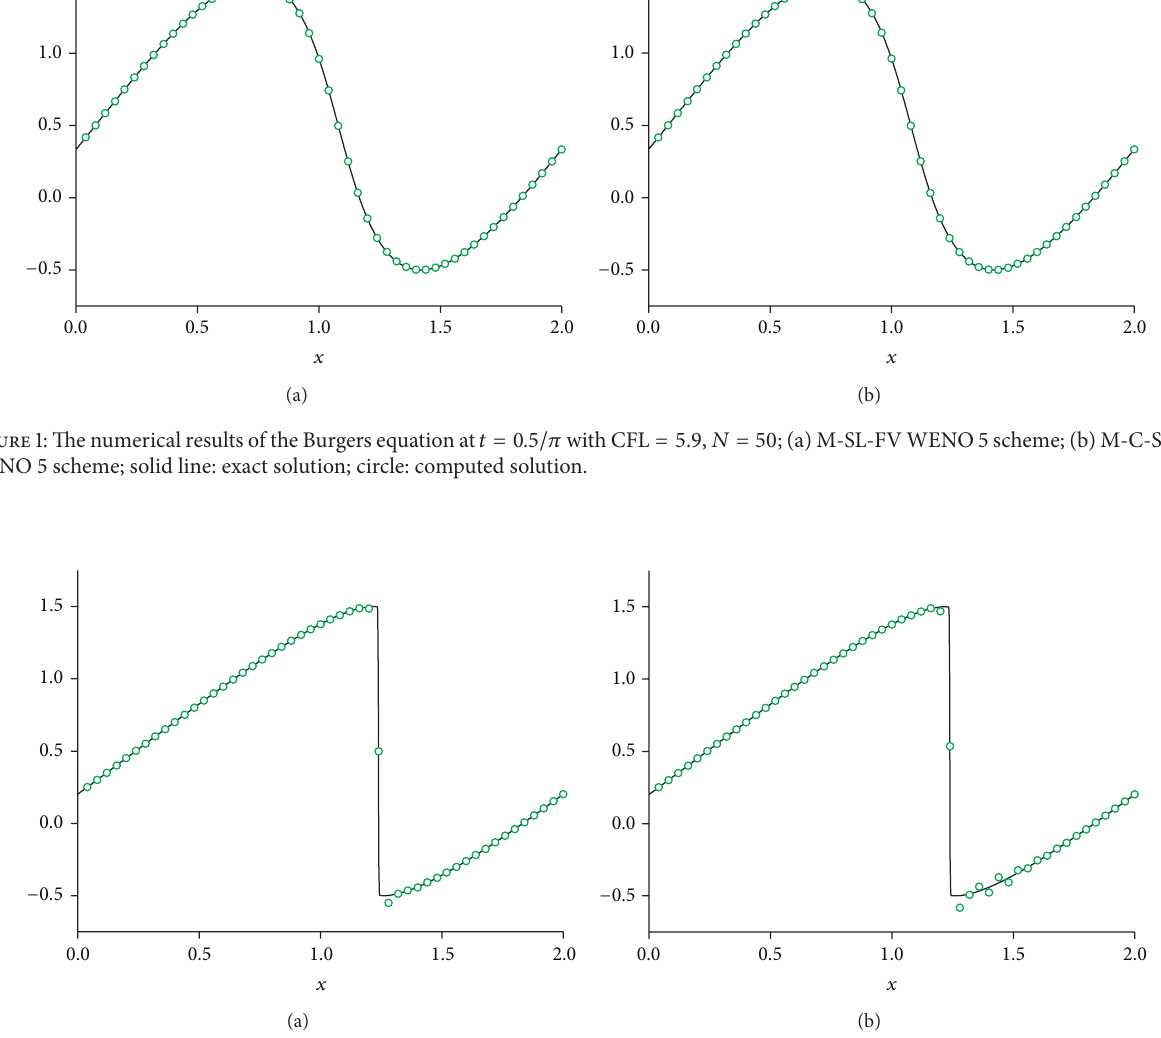
Figure 2: The numerical results of the Burgers equation at 𝑡 = 1.5/𝜋 with CFL = 5.9 , 𝑁 = 50 ; (a) M-SL-FV WENO 5 scheme; (b) M-C-SL-FD WENO 5 scheme; solid line: exact solution; circle: computed